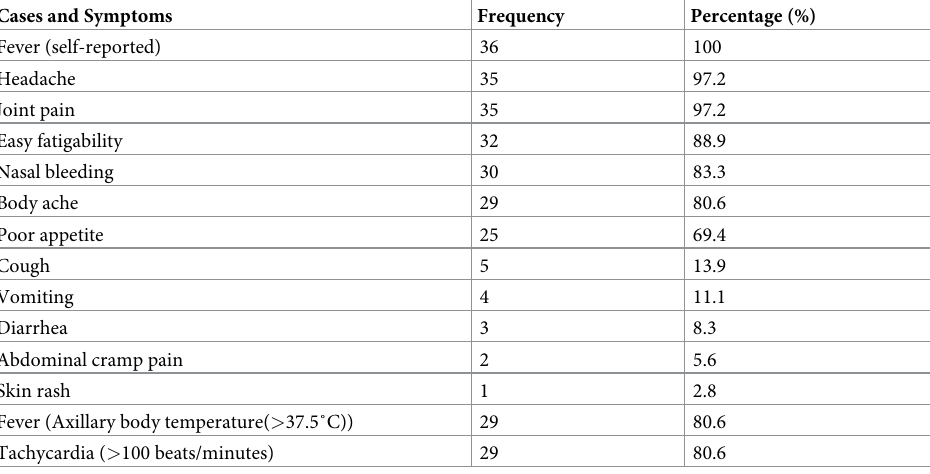
Table 1. Clinical presentation of patients treated as LBRF at Jimma Medical Center, Ethiopia, May–July